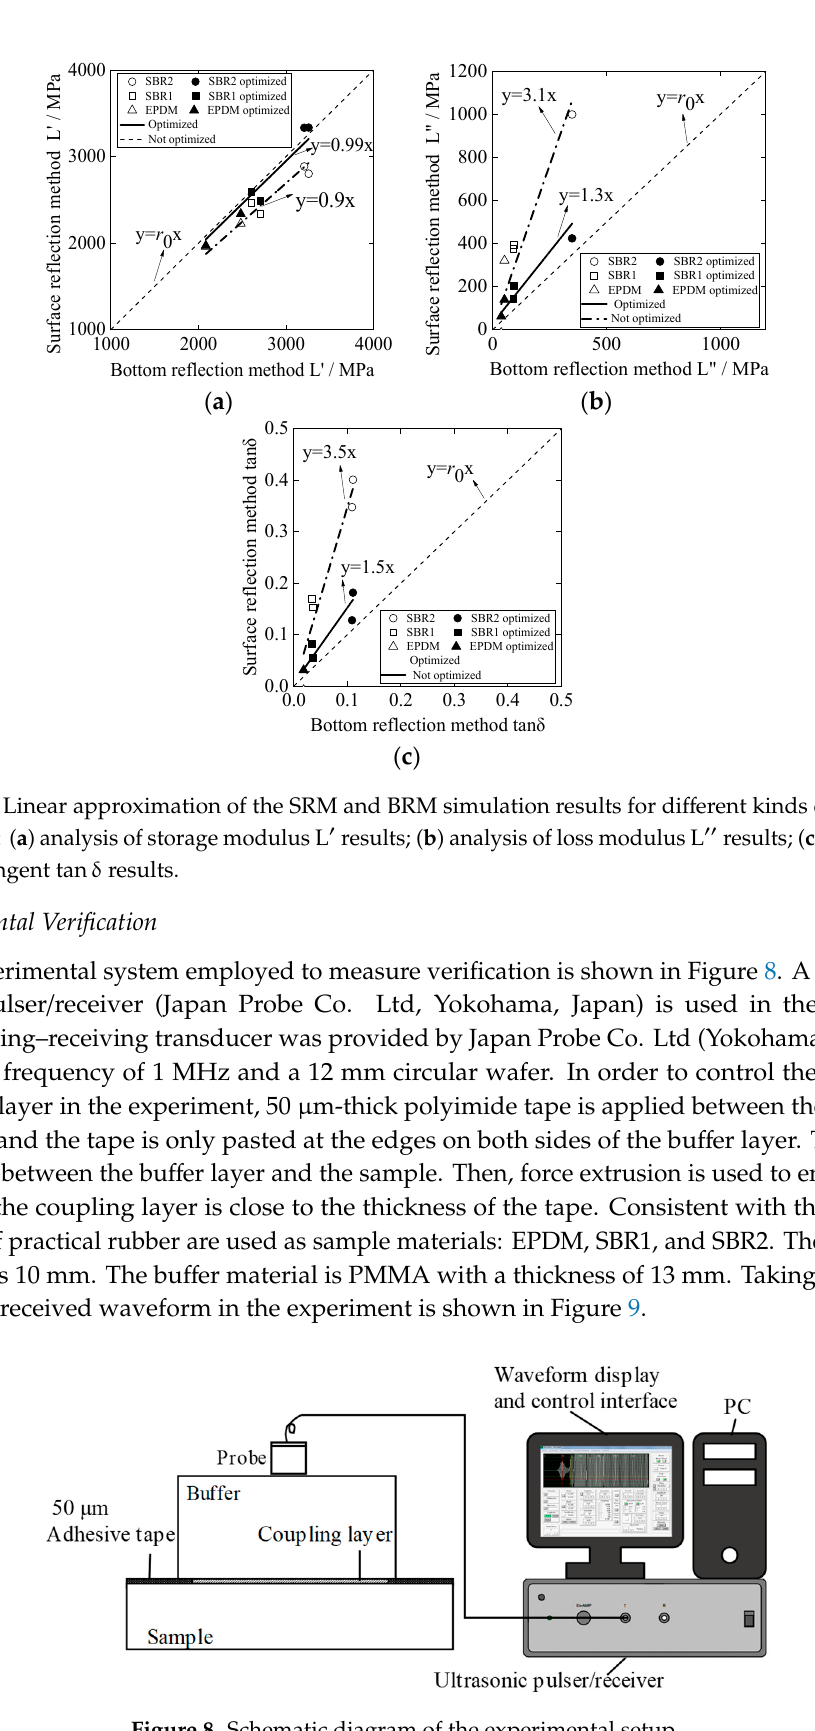
( b ) Figure 9. Received waveform of the same 13 mm-thick PMMA and 10 mm-thick EPDM material (1 MHz) by experiment: ( a ) the reflection wave form of the bottom of the buffer with an experiment; ( b ) the reflection wave form of the surface and bottom of the sample with an experiment. The received waveforms are similar to the simulation results in the experiment, but more chaotic than the simulated receiving waves since the buffer material damping coefficient is not 0 in reality and the coupling state is ideal in the simulation process but not in the experiment. Figure 10a,b shows the relationship between the SRM results and BRM results for storage modulus L (cid:4593) and loss modulus L (cid:4593)(cid:4593) , respectively, which included the following situations: with optimization (considering the thickness of the coupling layer) or without optimization (not considering the thickness of the coupling layer). Through comparing correlation coefficients, after optimization, the value r for L (cid:4593) shifted from 0.9 to 0.93, while value r for L (cid:4593)(cid:4593) shifted from 4.2 to 2.5. This phenomenon is almost consistent with the simulation result shown in Figure 7, and the optimized results are more fitting with 𝑦 = 𝑟 (cid:2868) 𝑥 . The loss tangent tan δ , which can be used to evaluate